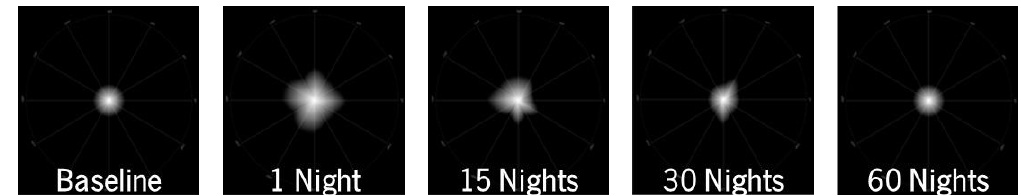
Figure 2. Illustration of the average light disturbance size at BL and after 1, 15, 30, and 60 nights of OK lens wear. The figures represent the mean values of the sample. Table 2. Light disturbance index (LDI) (%; mean ± SD), irregularity of the disturbance or BFCIrreg and the SD of BFCIrreg (mm; mean ± SD) at BL and after 1, 15, 30, and 60 nights of OK lens wear.